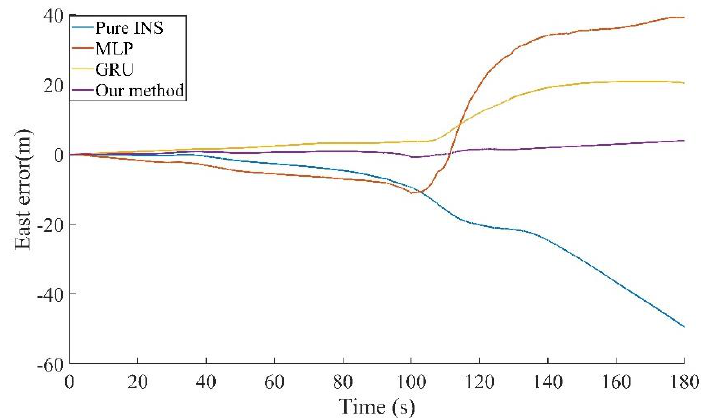
Figure 12. The east position error result of 180 s outage of Experiment 1.